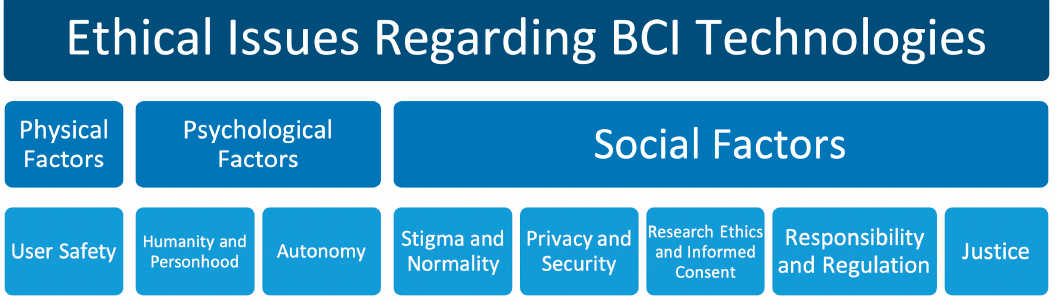
Figure 1. Overarching Themes in Brain–Computer Interface (BCI)